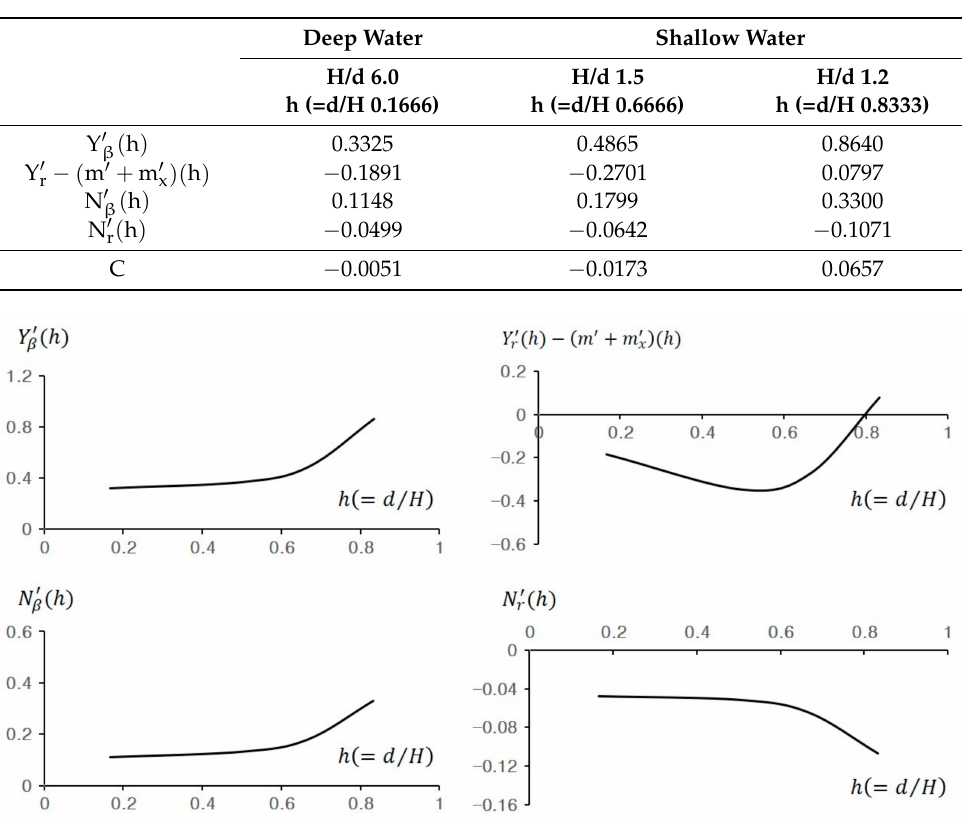
Figure 9. Change of linear hydrodynamic coefficients by ship-draft to water-depth